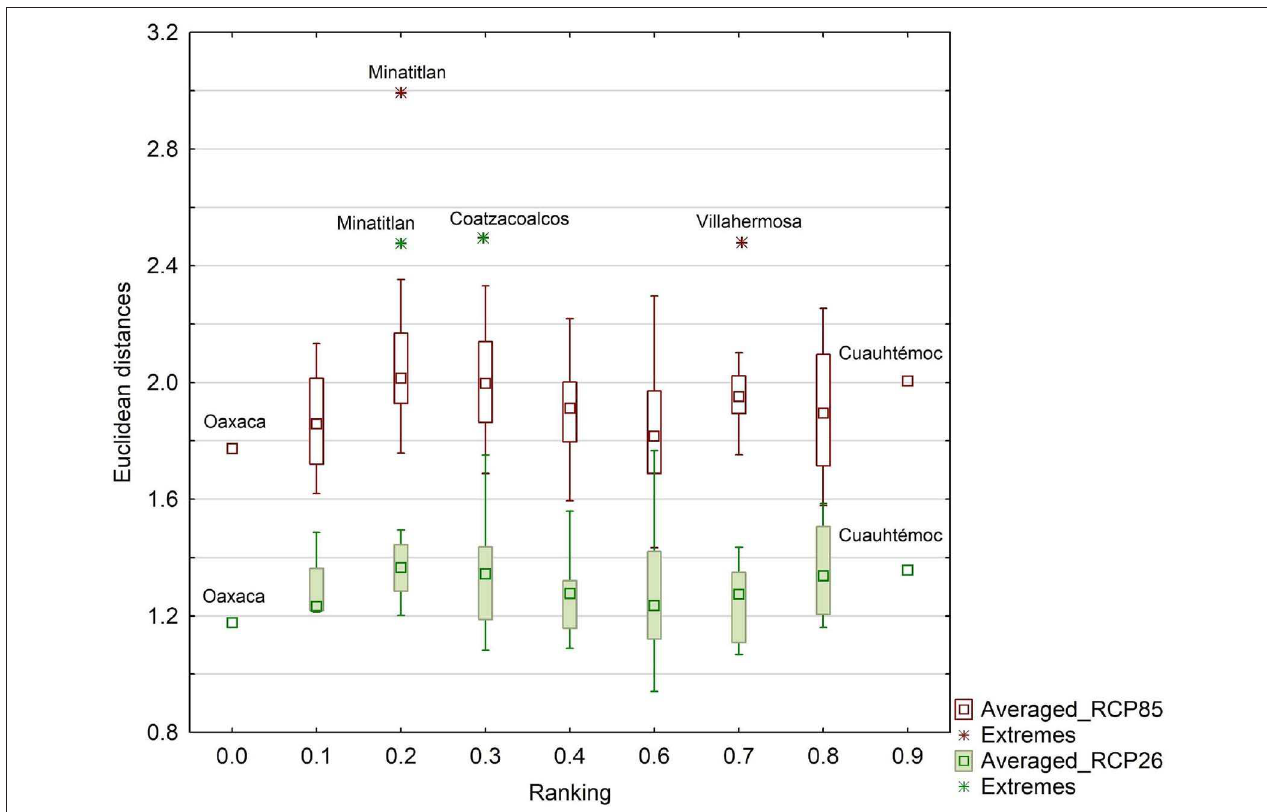
FIGURE 6 | Boxplots of the average Euclidean distances from four Global Circulation Models for RCP 2.6 and RCP 8.5. The Euclidean distances capture the exposure of each city to novel climates.